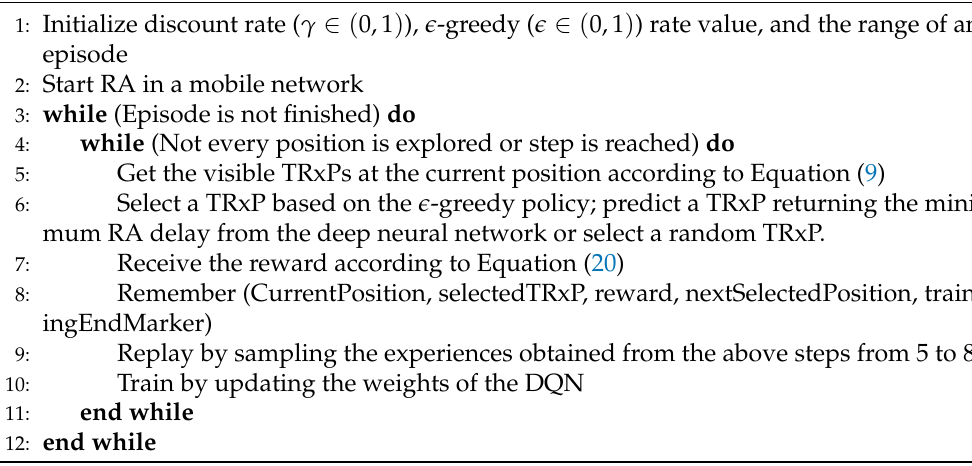
Algorithm 1 DQN-based Intelligent TRxPs Selector Algorithm: Training.